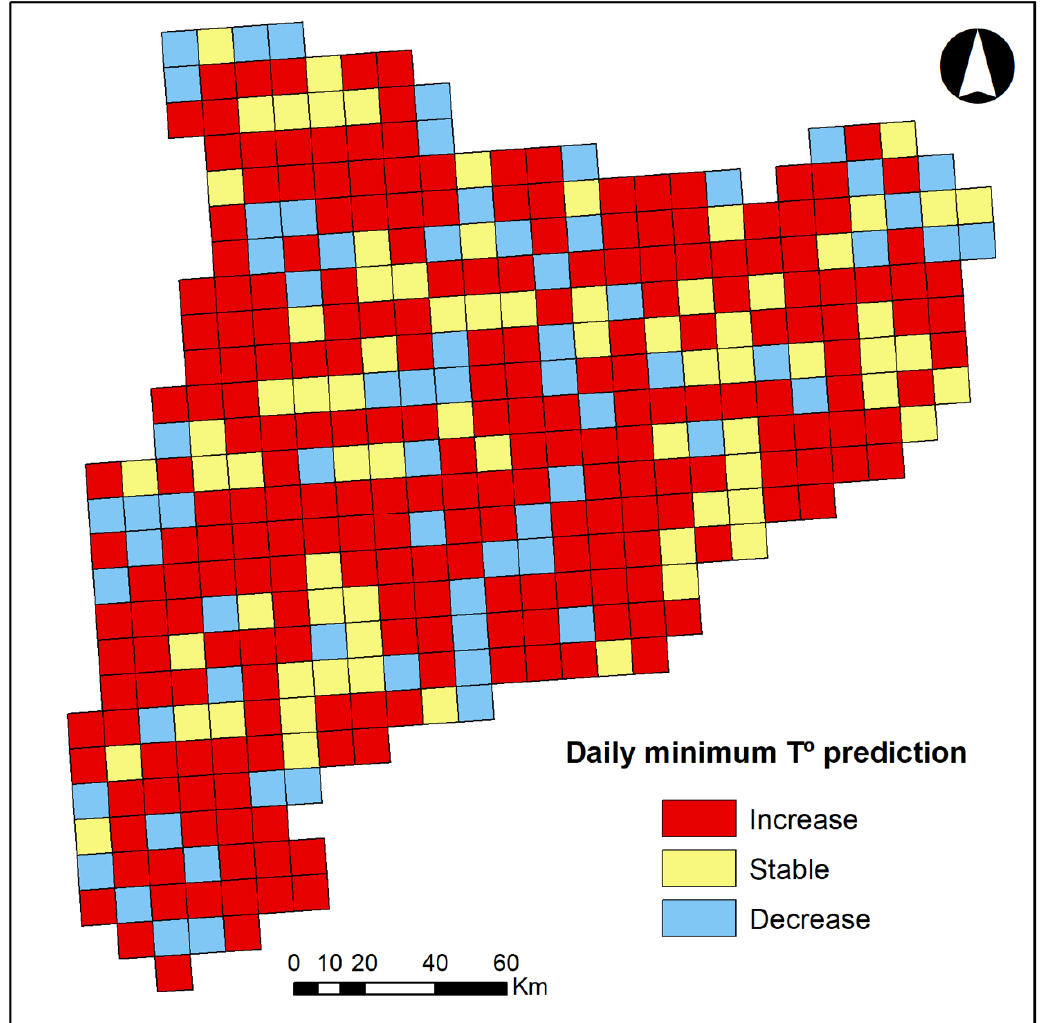
Figure 1. Daily maximum and minimum temperature prediction and latitude variation, with a maximum in 4.619.000 coord Y (ETRS89 31N).